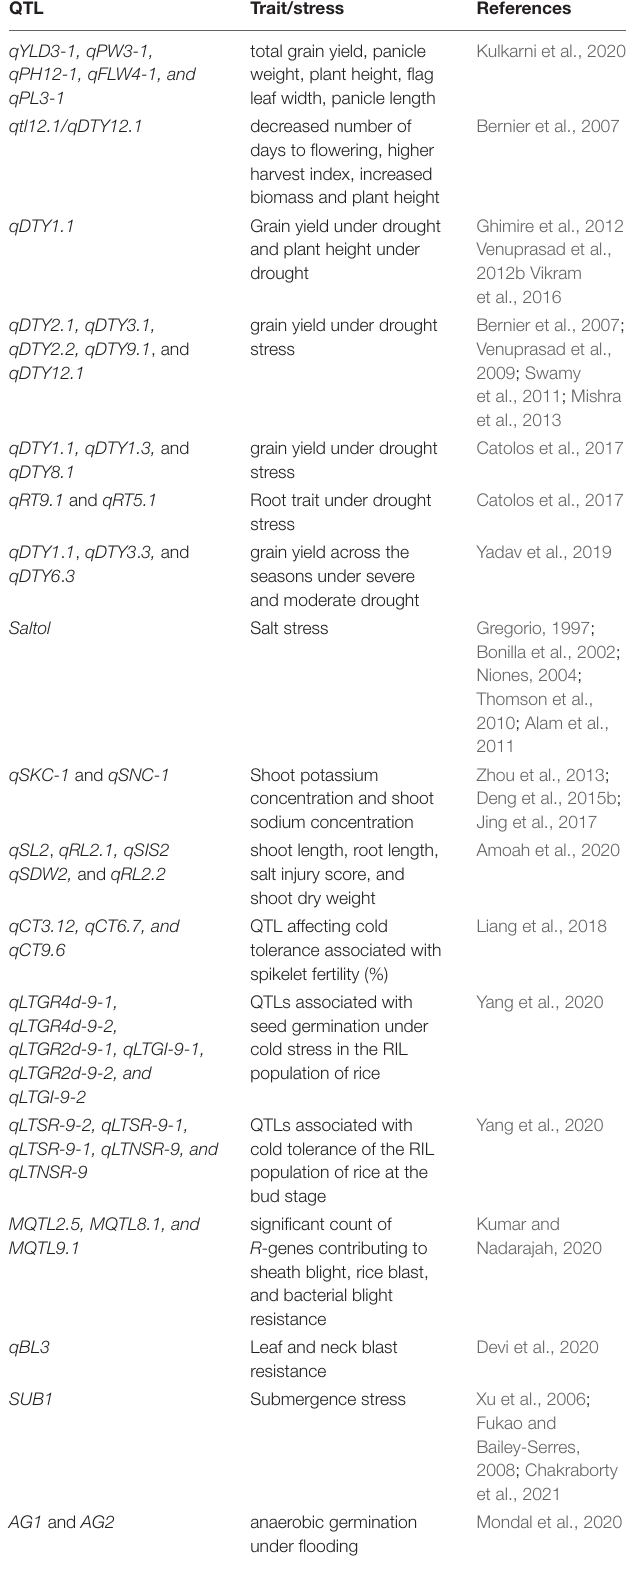
TABLE 1 | List of QTLs in rice trait improvement and stress